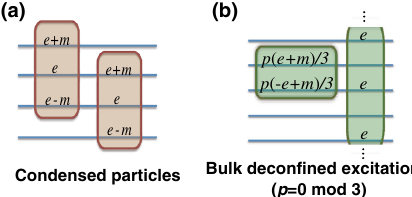
FIG. 7. (a) The condensed particle in the coupled Z system. This case is the same as the case studied in Sec. III A, but here, we focus on the cases with p ≡ 0 ð mod 3 Þ . (b) The bulk deconfined excitations in this system. The one on the left is a point particle, while the one on the right is a string excitation. They have nontrivial mutual